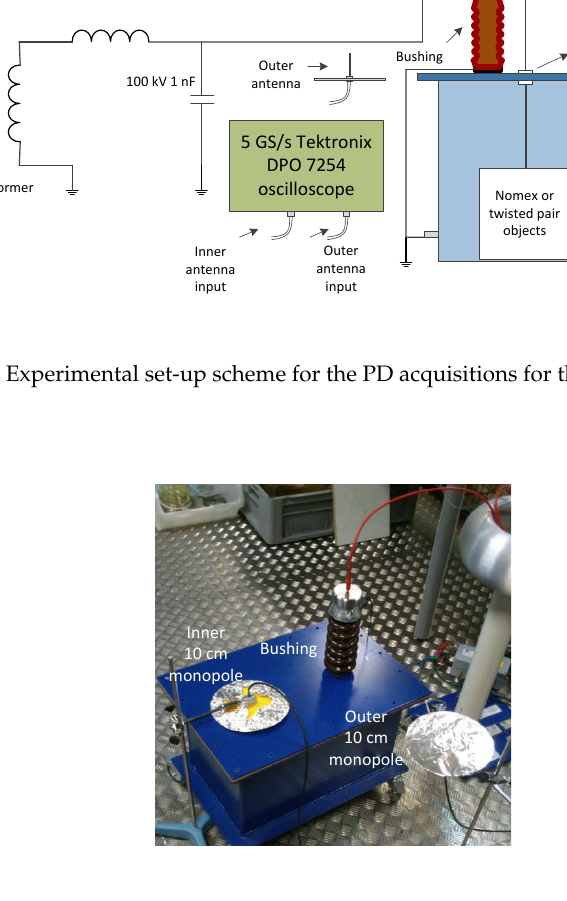
Figure 7. Layout of 10 cm monopole antennas with ground plane, inside and outside the tank, to measure surface PD from the bushing insulator at 12